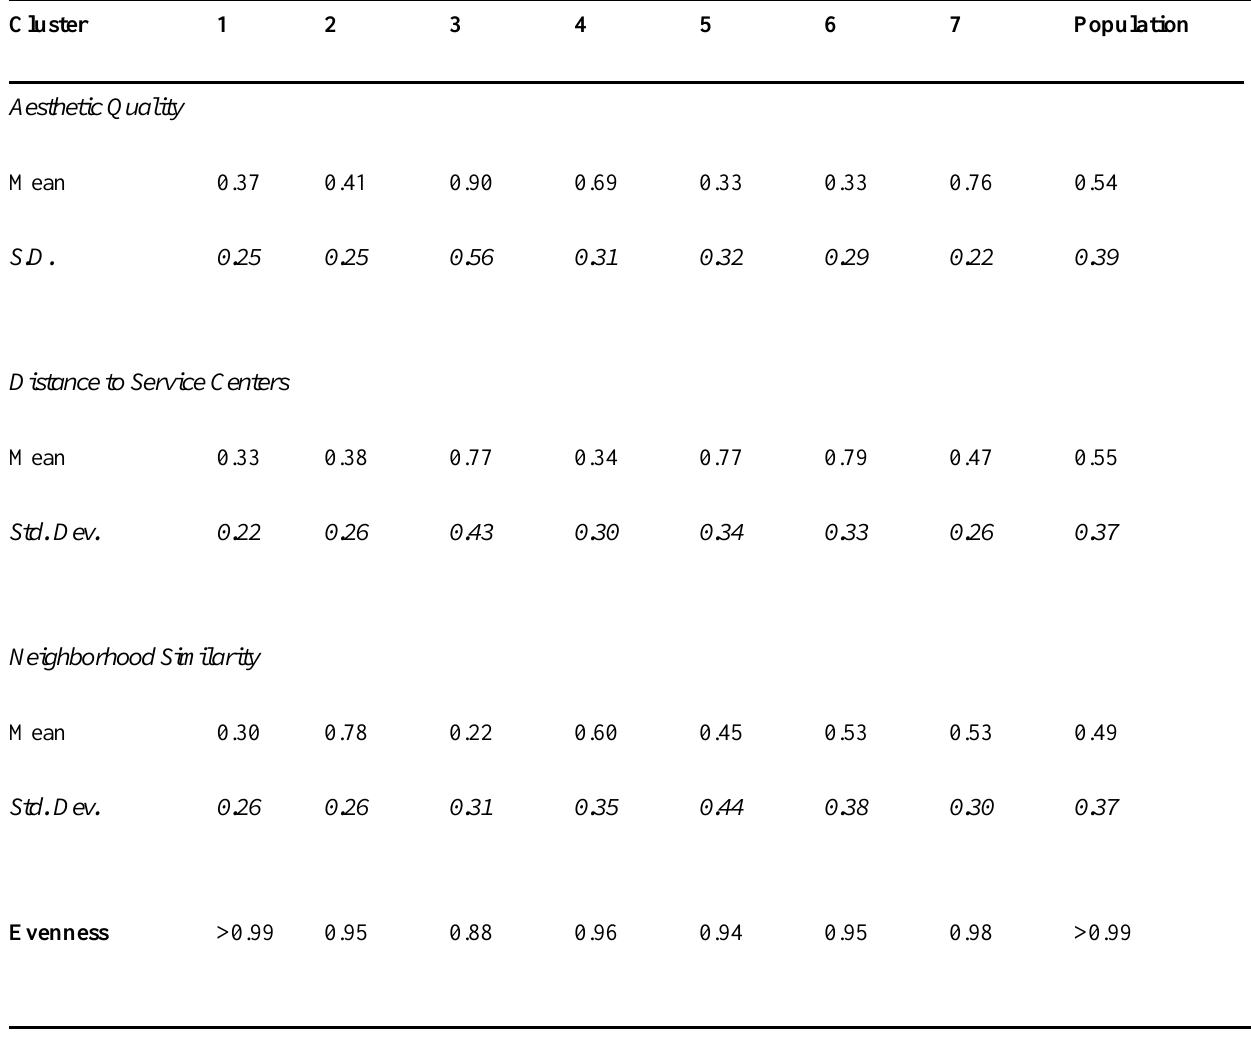
Table 2. Means and standard deviations of preference weights across the entire survey population and for each group resulting from the analysis in Fernandez et al. (2005). 1 2 3 4 5 6 7